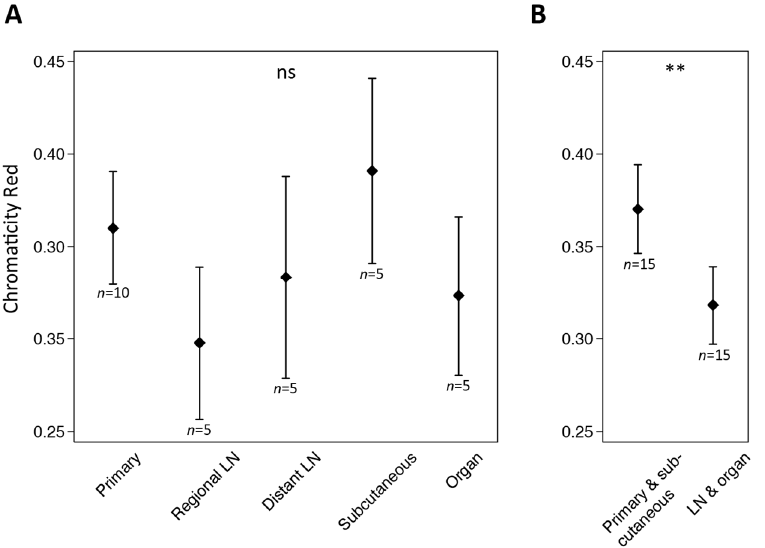
Figure 5. Mean red chromaticity level of annotated tumor cells with 95% confidence intervals for ( A ) each individual tumor type (primary melanomas and metastases of regional and distant lymph nodes (LN), subcutis, and organs) and ( B ) tumors of the skin (primary melanomas and subcutaneous metastases) versus metastatic tumors of LN and organs. (ns, not significant; ** very significant). By combining primary melanomas and subcutaneous metastases ( n = 15), the mean red-chromaticity level was 0.37 (95%CI, 0.35 to 0.39) while the mean of organ and lymph-node metastases ( n = 15) was 0.32 (0.30 to 0.34); p = 0.002 (Figure 5B). When analyzed separately, the intensity level of SOX10 was also significantly higher for primary melanomas ( n = 10; p = 0.02) and for subcutaneous metastases ( n = 5, p = 0.002) when compared with both organ and lymph-node metastases ( n = 15).